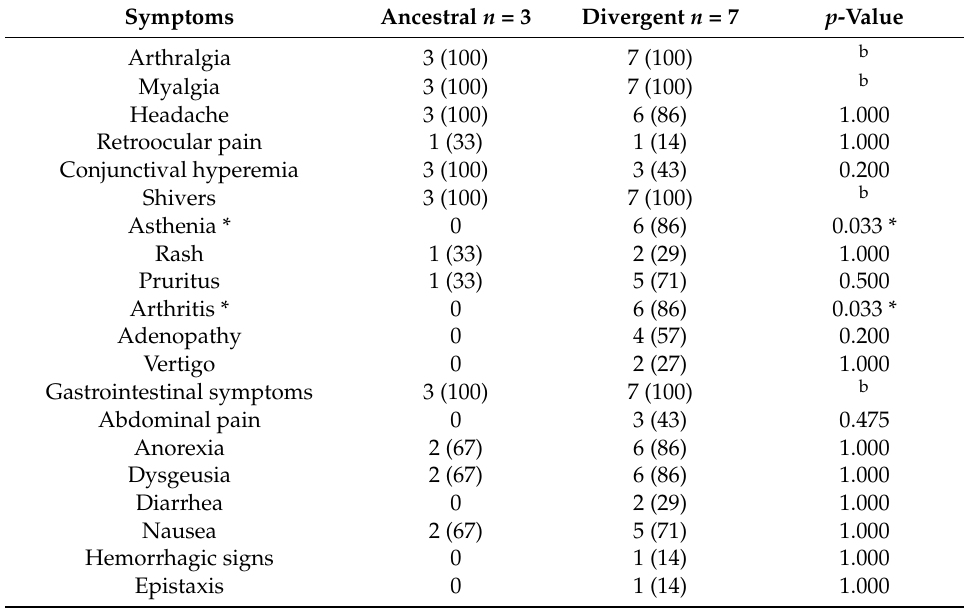
Table 5. Clinical features of patients infected with the isolated CHIKV strains a